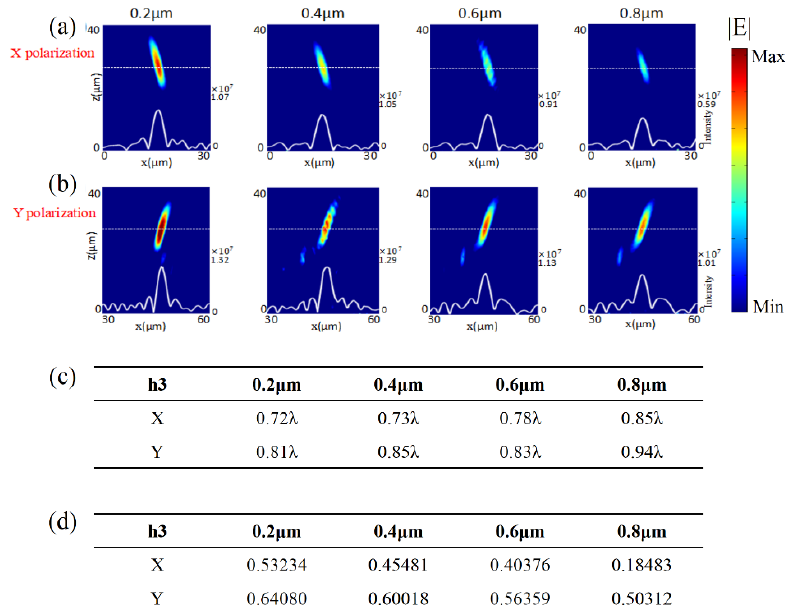
Figure 5. Focusing performances of the transmission metalens at a wavelength of 4.2 μm when the fabrication error of elliptical hemisphere, with h 3 = 0.2 μm, 0.4 μm, 0.6 μm, and 0.8 μm (from left to right), emerged in the GaAs nano-bricks. Distributions of light intensity in the x - z plane under normal incidences of ( a ) x - and ( b ) y -polarization. The white solid and dash lines are the intensity-distribution curves and the positions of focal planes, respectively. The number on the right side of each figure is the value of light intensity at the focus. ( c ) Simulated FWHM for each case. ( d ) Simulated focusing efficiency for each case.